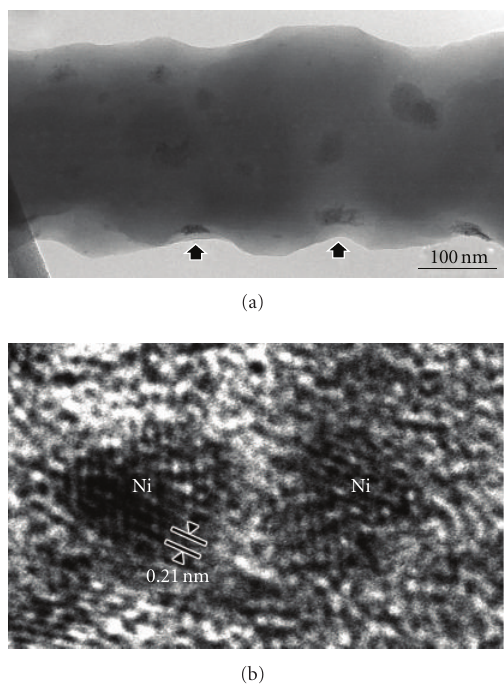
Figure 2: (a) Bright-field images of Ni-doped C 60 nanowhiskers synthesized using isopropyl alcohol with concentration of 0.68 M Ni(NO 3 ) 2 · 6H 2 O. The arrows indicate Ni particles in dents. (b) High-resolution image of Ni particles in the NW in (a).